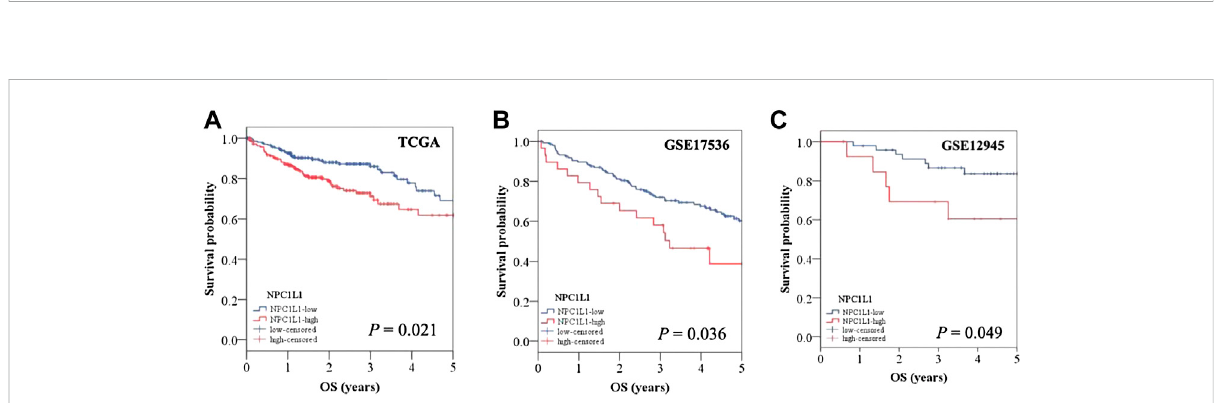
FIGURE 4 OSofCRCpatientswithahighNPC1L1expressionwassigni fi cantlylowerthanthatofCRCpatientswithalowNPC1L1expression.Theresultsof the two datasets (GSE17536 and GSE129451) collated in the CRC patients strati fi ed into NPC1L1-low and NPC1L1-high groups also showed results consistent with those obtained from the analysis of TCGA dataset (Kwon et al.,